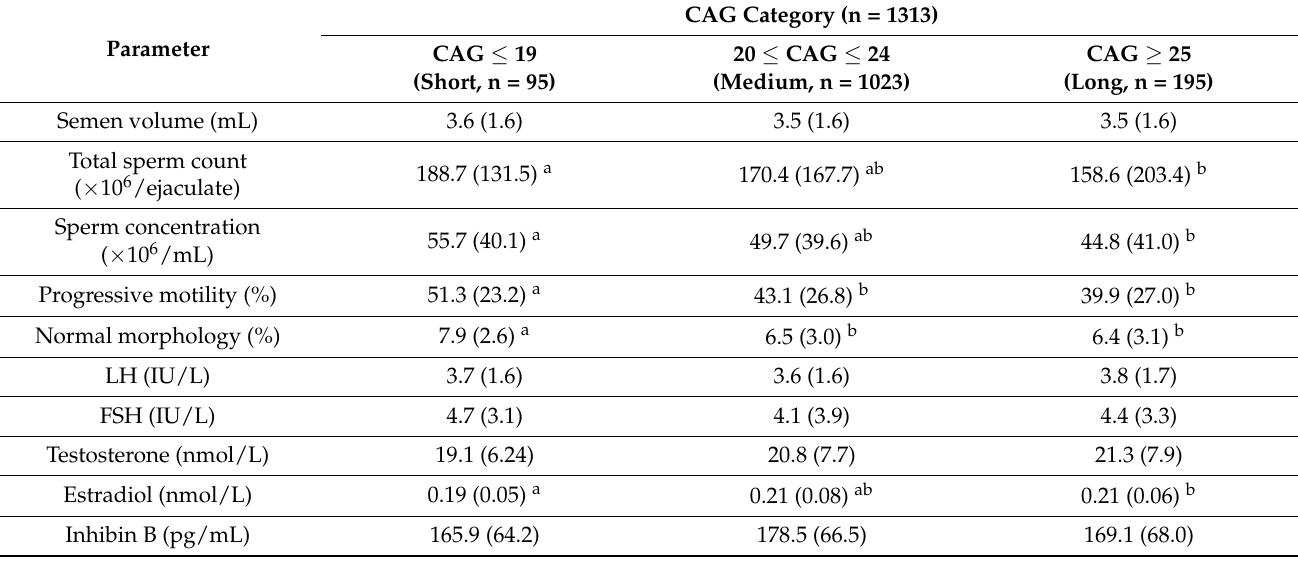
Table 2. Semen and hormonal characteristics of men stratified on various CAG categories in the entire Russian study